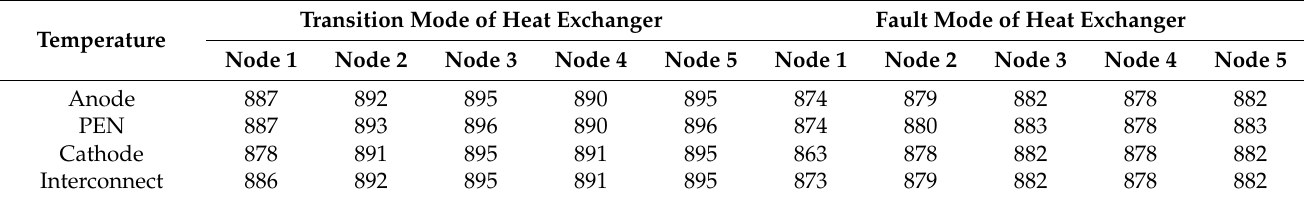
Table 7. Temperature distribution of SOFC stack nodes due to the heat exchanger fault.